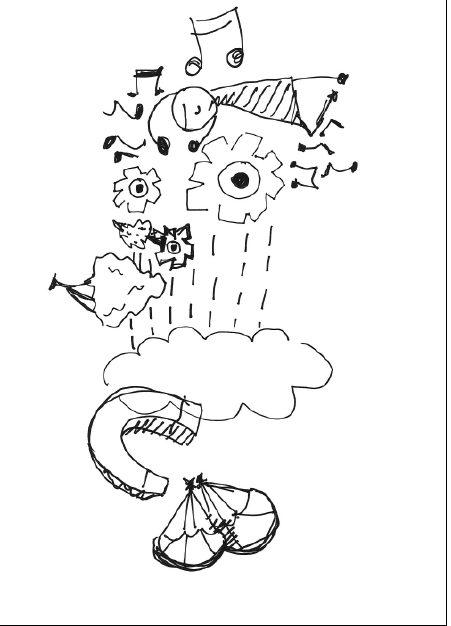
Figure 1. Work by PT1